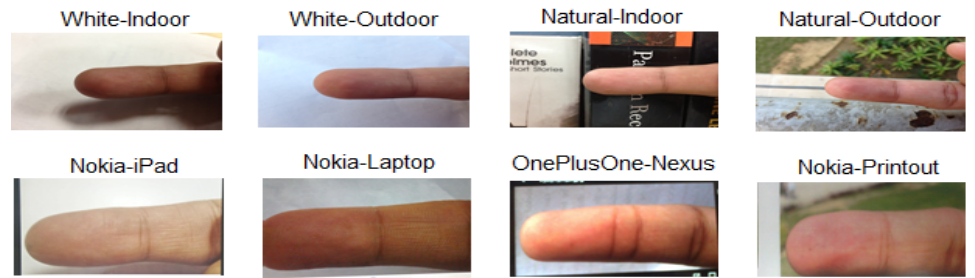
Figure 6. Examples of finger photos acquired from live human fingers with white and natural background as well as of display spoof